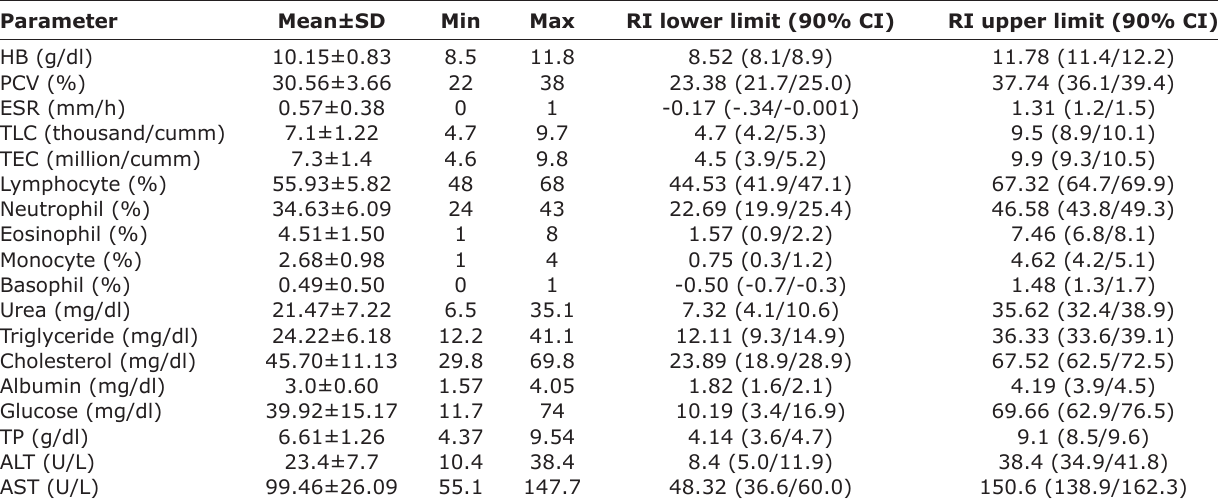
Table-1: Biochemical and hematological profiles of indigenous sheep (O. aries) , Bangladesh (n=41), with RI. Parameter